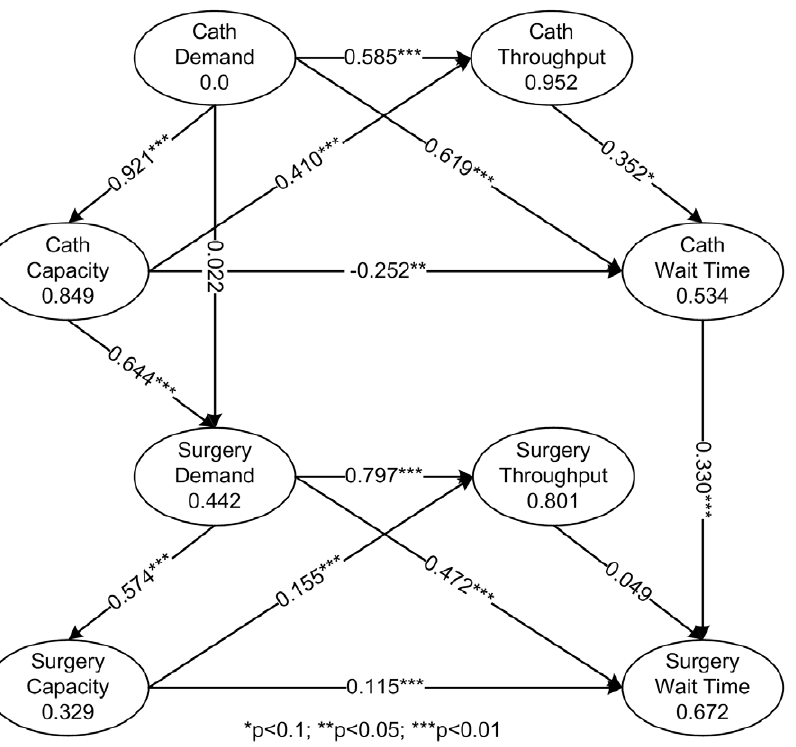
Figure 4. PLS test results based on a formative measurement model. (Cath: the abbreviation of catheterization; Surgery: the shorter form of cardiac surgery.)